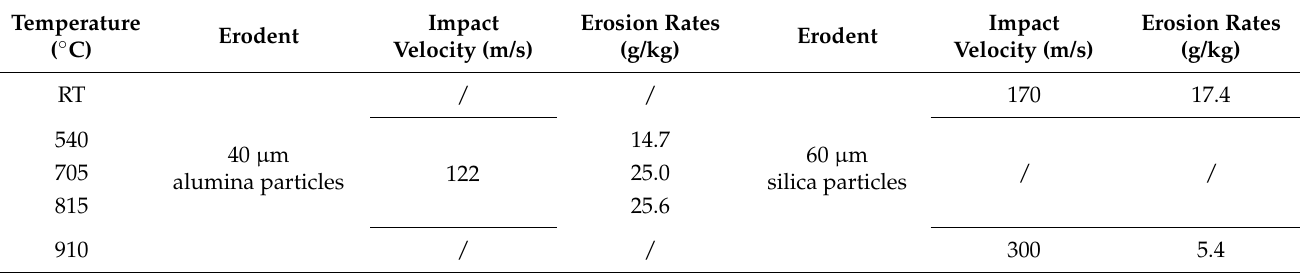
Table 5. The experimentally measured erosion rates at an impact angle of 90 ◦ for EB-PVD TC versus temperature